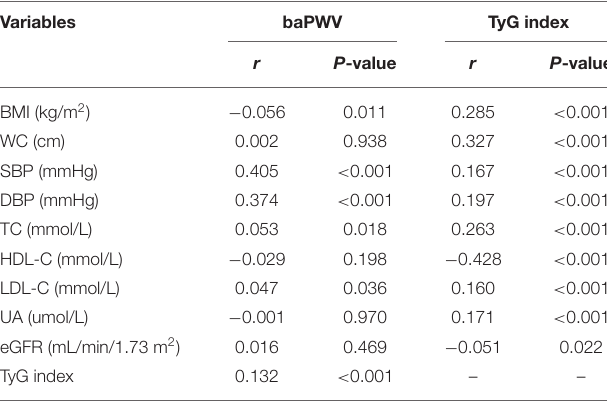
TABLE 2 | Age- and sex-adjusted correlation between TyG index, baPWV, and clinical variables. Variables